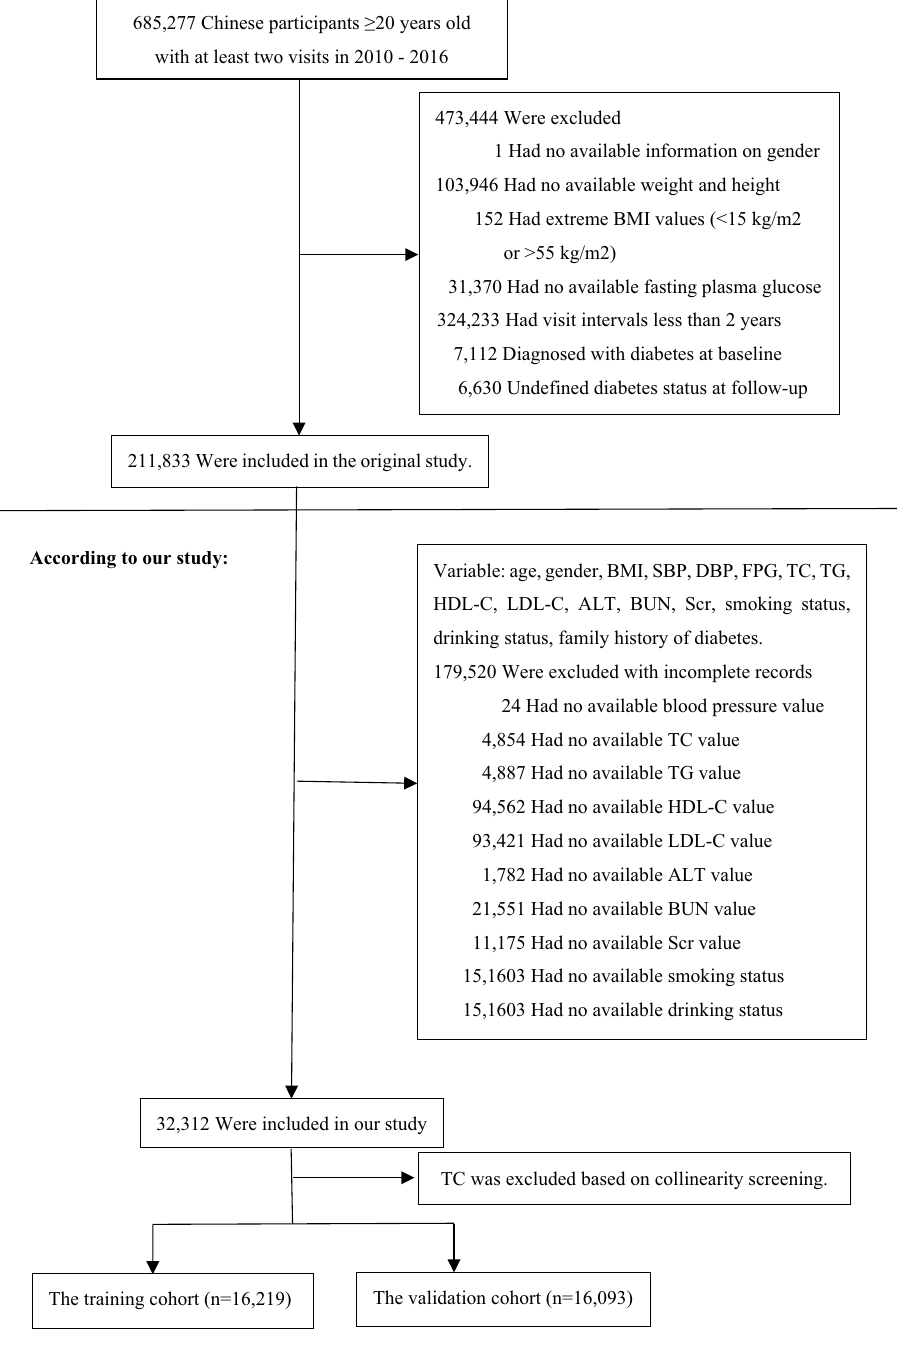
Figure 1. Flowchart of study